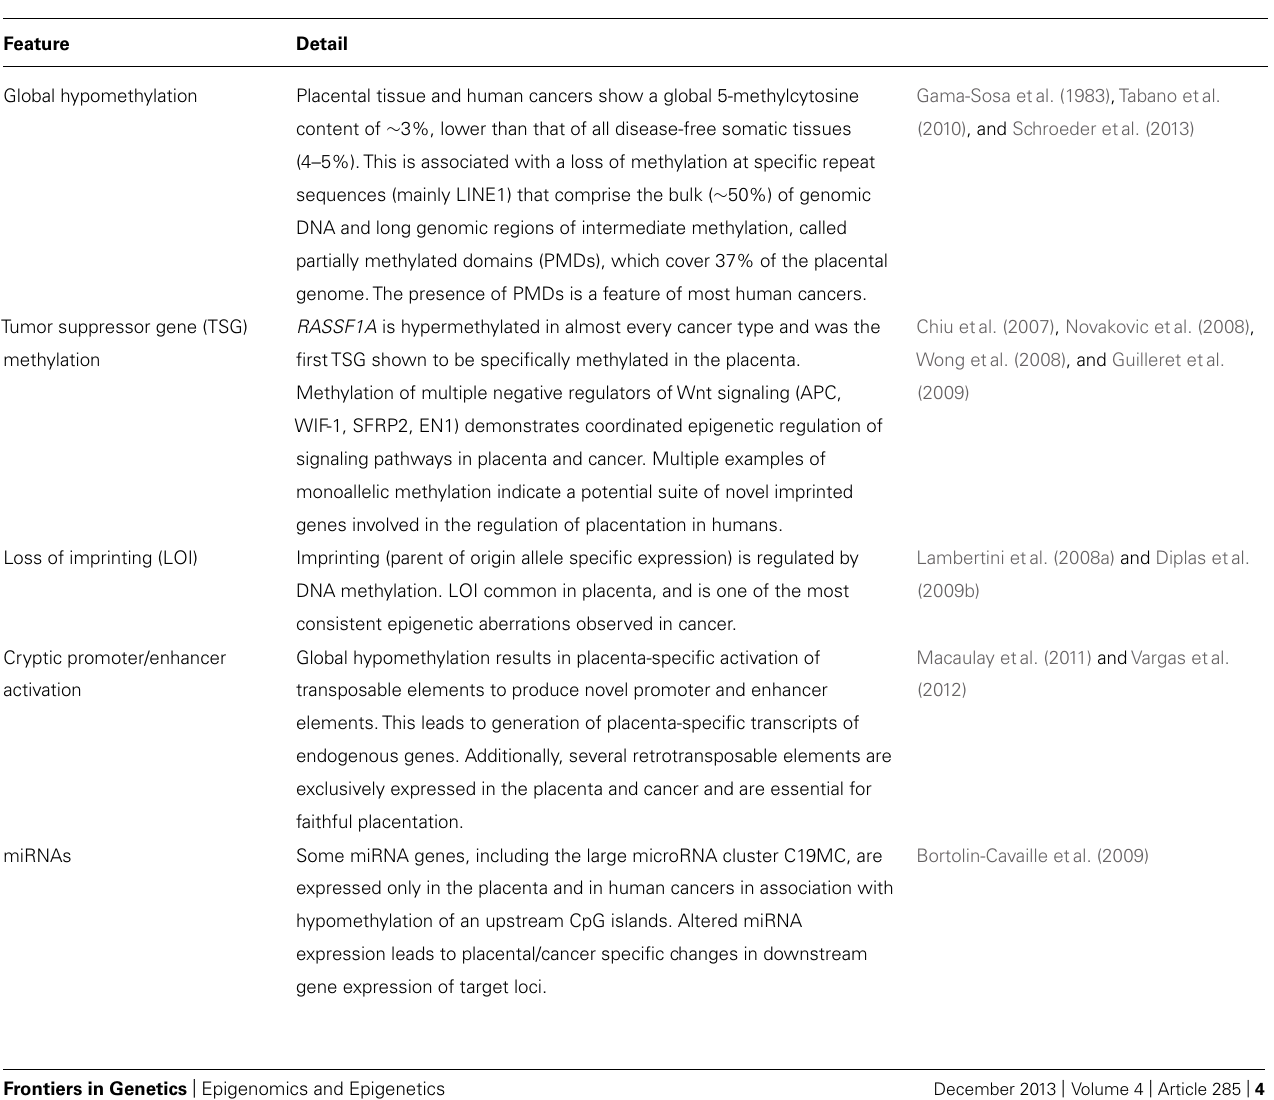
Table 1 | Key epigenetic similarities between the placenta and human